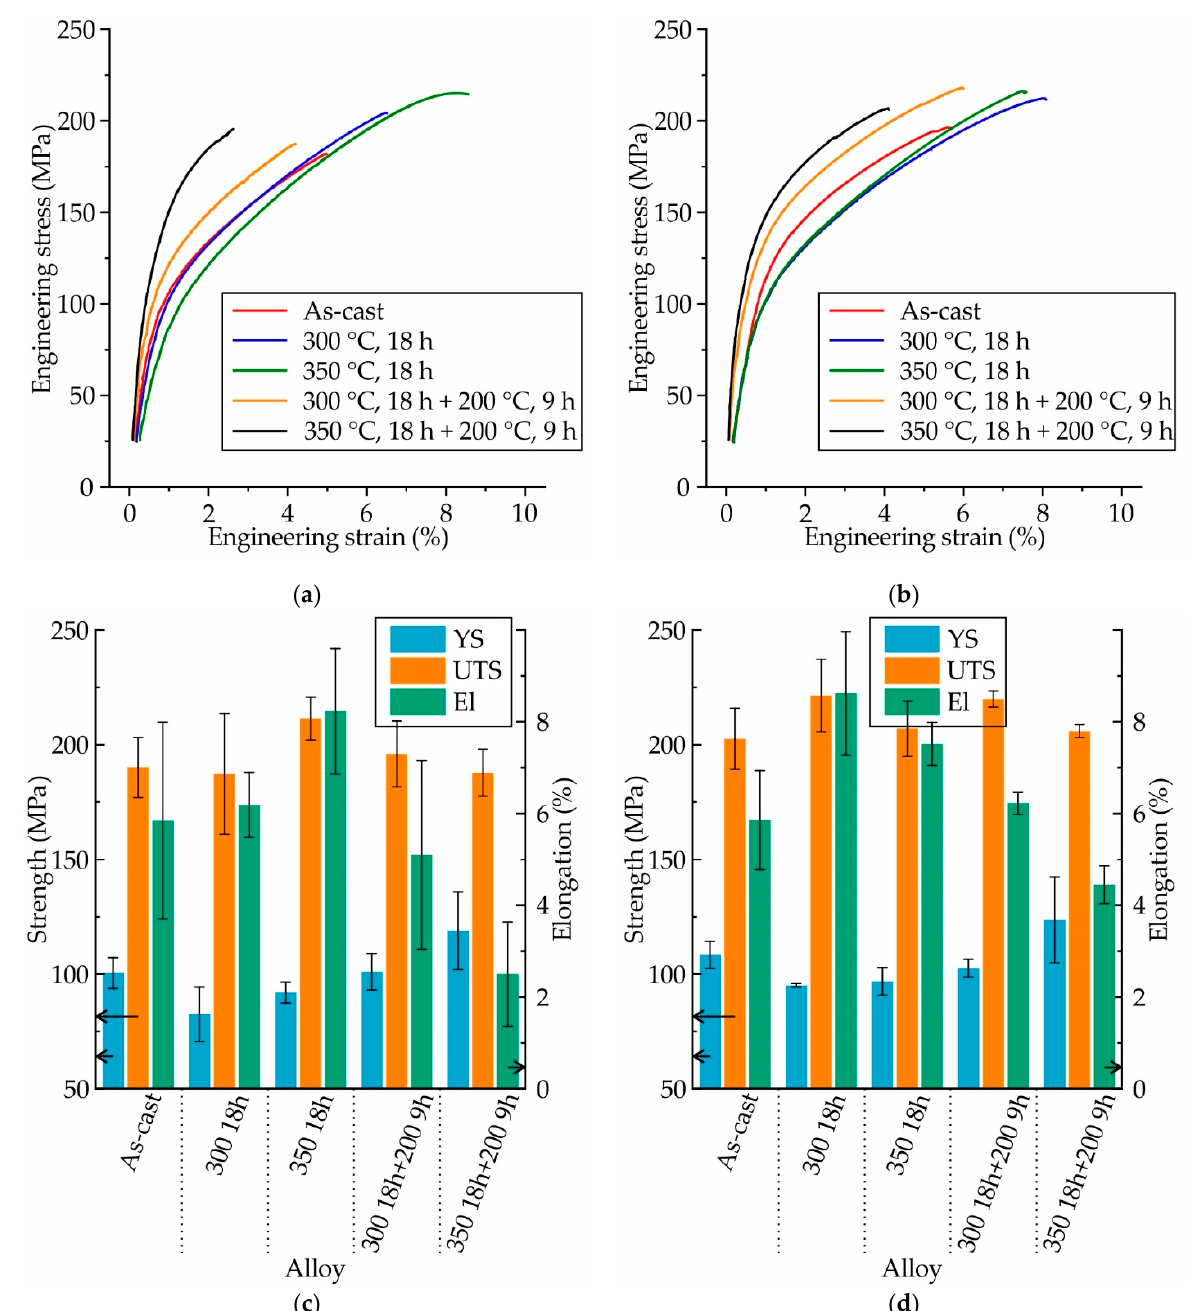
Figure 8. ( a , b ) Engineering stress–strain curves and ( c , d ) mechanical properties (YS: yield strength; UTS: ultimate tensile strength; El: elongation at fracture) obtained during the tensile testing of the as-cast and heat-treated ( a , c ) MgZn4Ga4 and ( b , d ) MgZn4Ga4Y0.5.